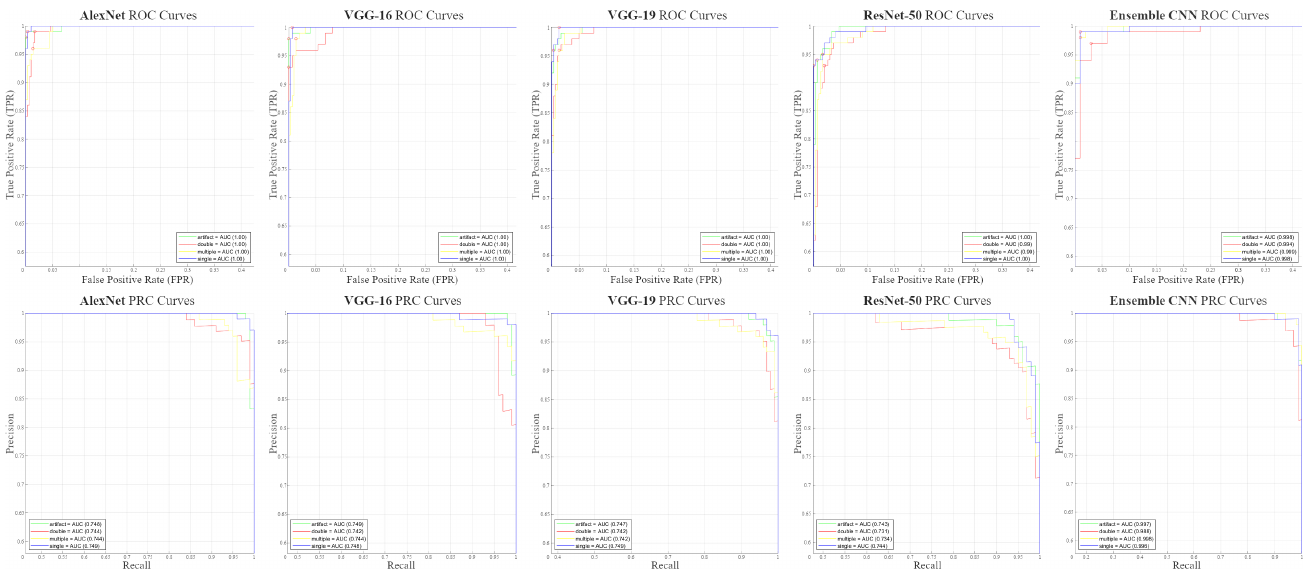
Figure 4. The ROC and PRC curves per pancreatic class, accompanied by their AUC values. The individual AlexNet, VGG-16, VGG-19, and ResNet-50 models have more difficulty differentiat- ing between “double” and “multiple” objects than “single” and “artifact”. According to the OvR method, the distinction of the four classes is improved in the ensemble CNN classifier, but recog- nizing all “double” structures remains a challenge. The ensemble model’s high ROC-AUC ( ≥ 0.994) and PRC-AUC ( ≥ 0.996) values indicate a satisfactory performance for its voting system with high prediction